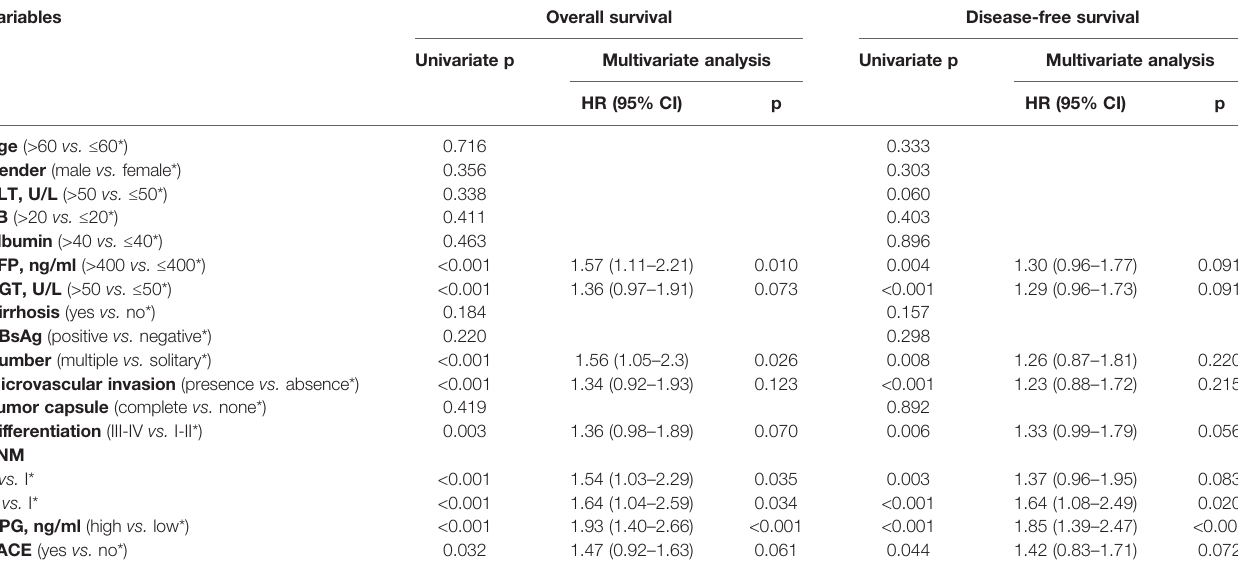
TABLE 2 | Univariate and multivariate Cox regression analysis for assessing the effect of different clinical variables on HCC patients ’ overall survival and disease-free survival in the unmatched population.